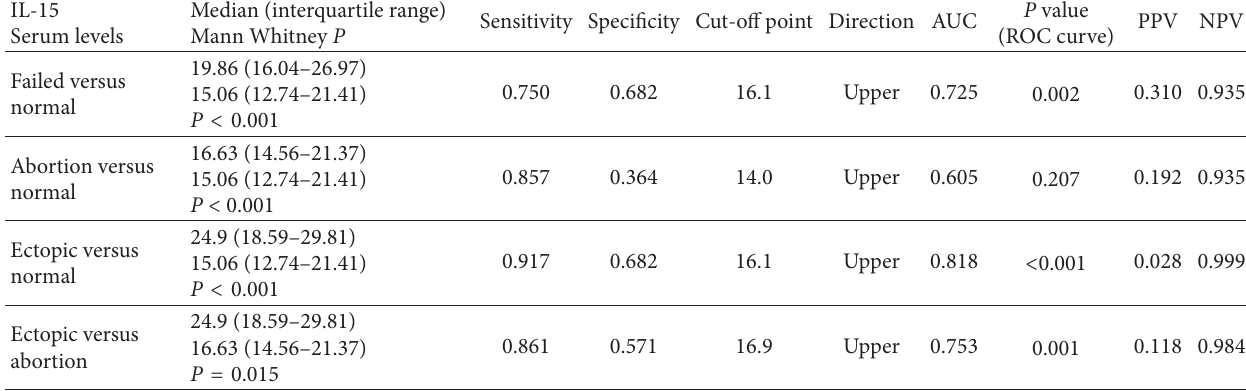
(b) Missed abortion versus ectopic pregnancy F 1: IL-15 ROC curves of normal versus failed pregnancy (a) and missed abortions versus ectopic pregnancies (b). T 2: IL-15 concentrations in 60 women with failed pregnancies, including 30 women with ectopic pregnancy (EP) and missed abortion (MA) and 33 women with intrauterine pregnancy (IUP). Median, interquartile range (IR) in pg/mL, and the Mann-Whitney P value are presented. Additionally sensitivity, speci�city, positive predictive value (PPV), and negative predictive value (NPP) were calculated and IL-15 values were plotted in ROC curves in order to further evaluate their diagnostic accuracy for the diagnosis of healthy IUP and for accurate discrimination of an EP from a MA. All AUCs are